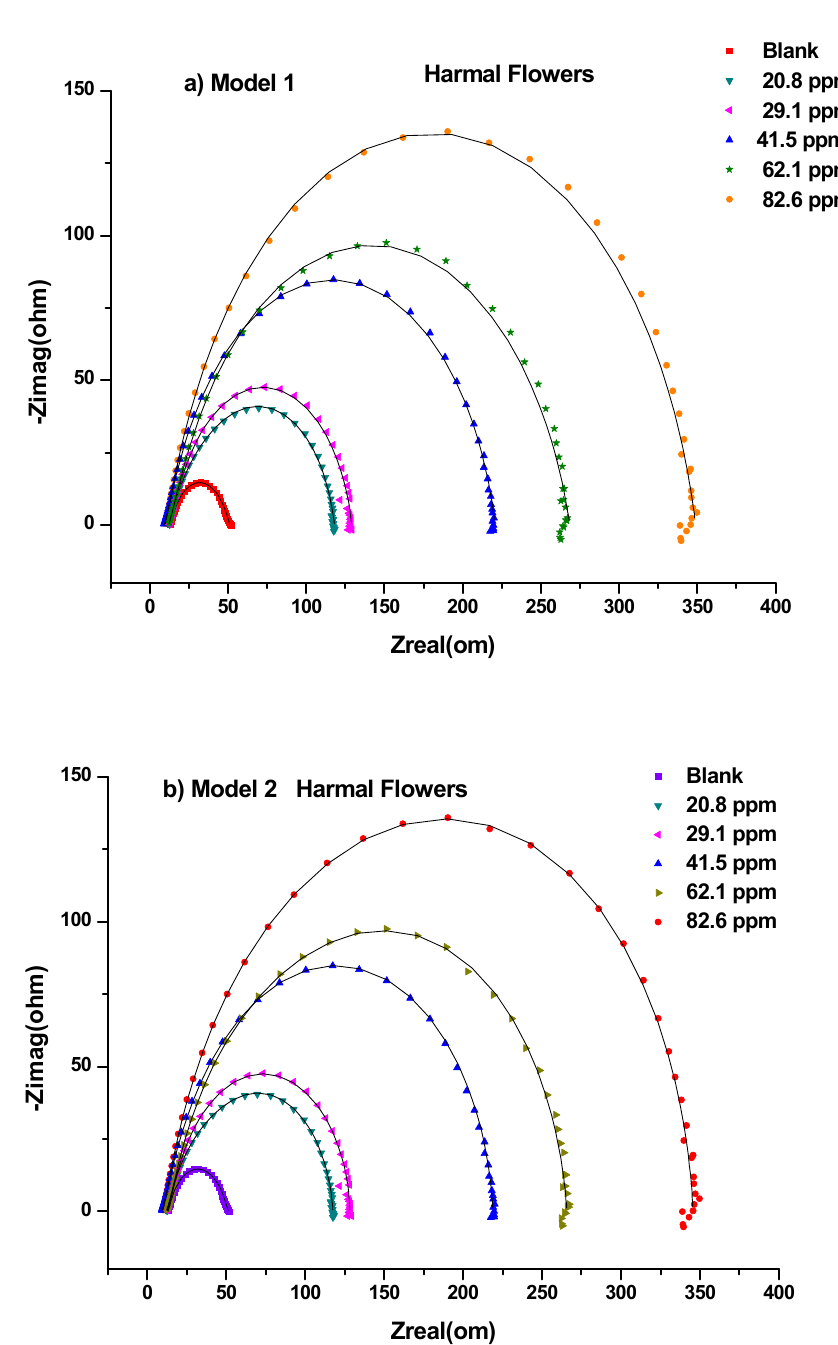
Figure 5. Nyquist plots for all concentrations of Harmal flower extract inhibitors in 0.25 M H 2 SO 4 at 298 K fitted by ( a ) Model 1 and ( b ) Model 2.